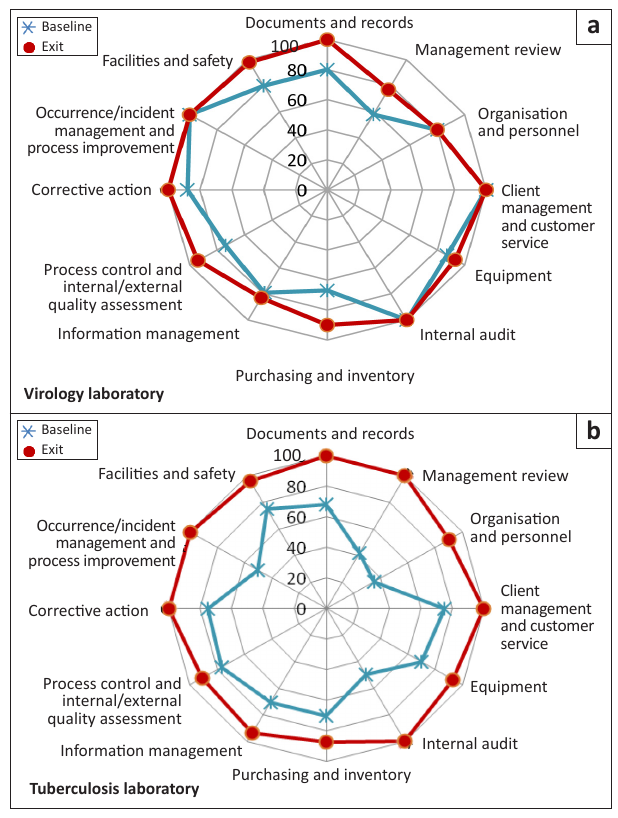
FIGURE 3: Comparison of performance of the virology and tuberculosis laboratories in the 12 quality system essentials using the WHO AFRO checklist.